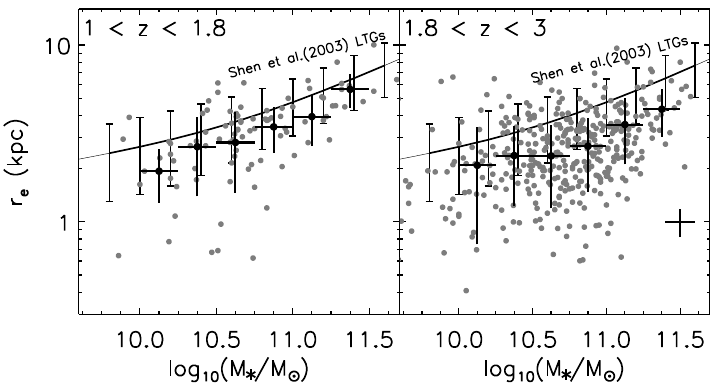
Fig. 3. Relation of stellar mass ( M ∗ ) and effective radius ( r e ) for ULIRGs in our sample in different redshift bins. The solid lines with 1 (cid:27) standard errors are provided by Shen et al. (2003) for local late-type galaxies (LTGs). Black solid circles represent the median sizes of ULIRGs in different M ∗ bins (∆log ( M ∗ =M ⊙ ) = 0 : 25). Typical error 10 bars for the data points are shown in the right